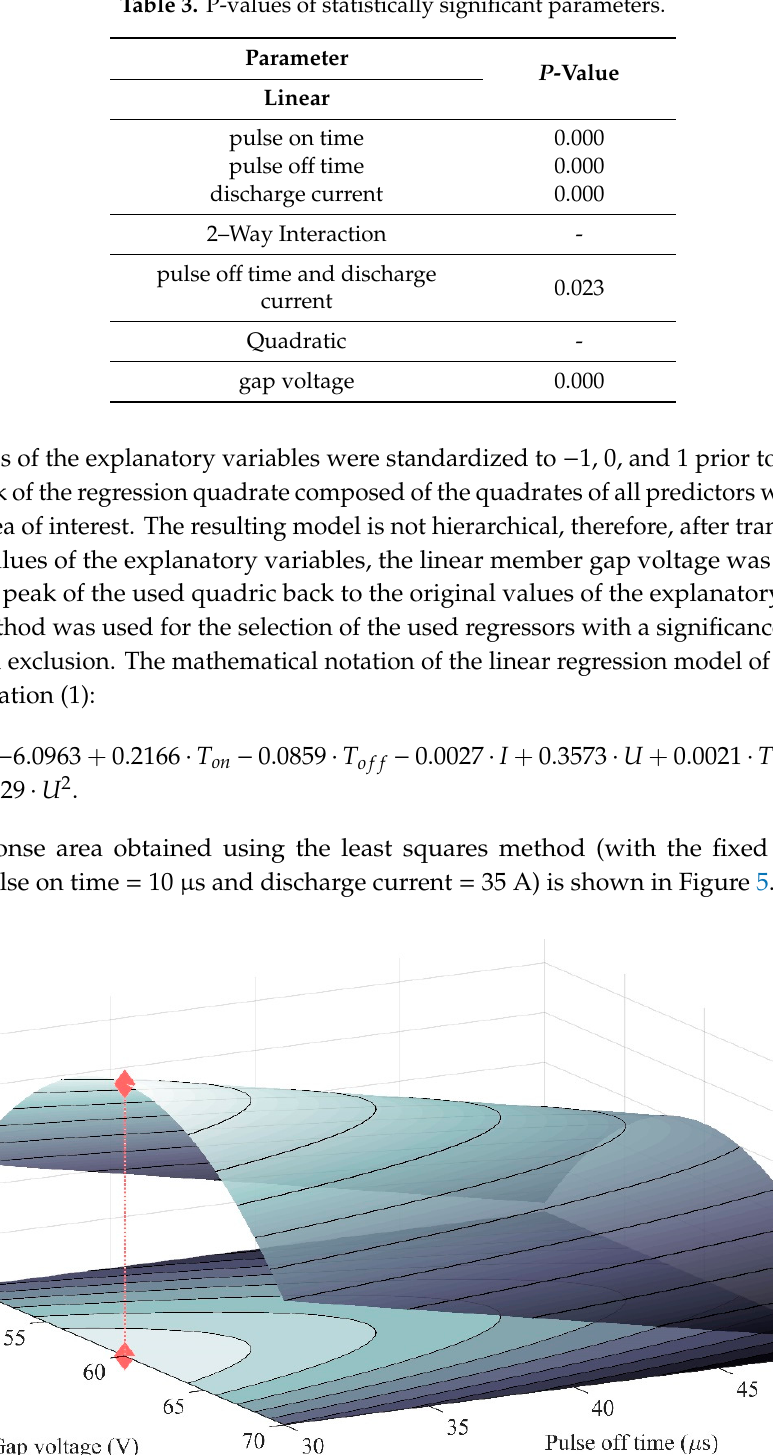
Table 3. P-values of statistically significant parameters.